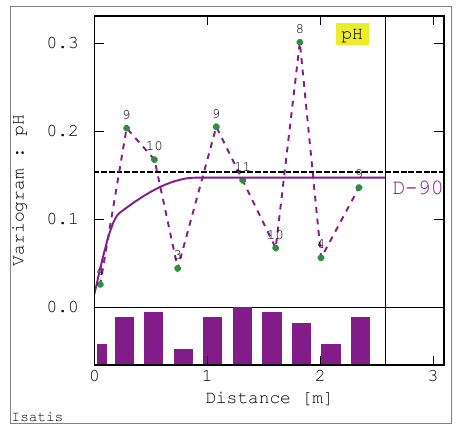
Fig. 19b. Directional semivariogram (D-90) of oxidation-reduction potential pH in underground water in Kłodzko intake area; 14 wells + 3 piezometers